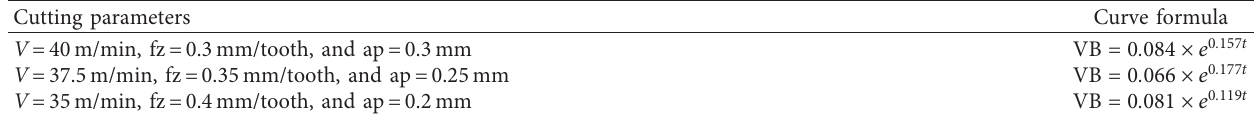
Table 6: Fitting curve formula of each set of cutting parameter on the cutting time. Cutting parameters Curve formula